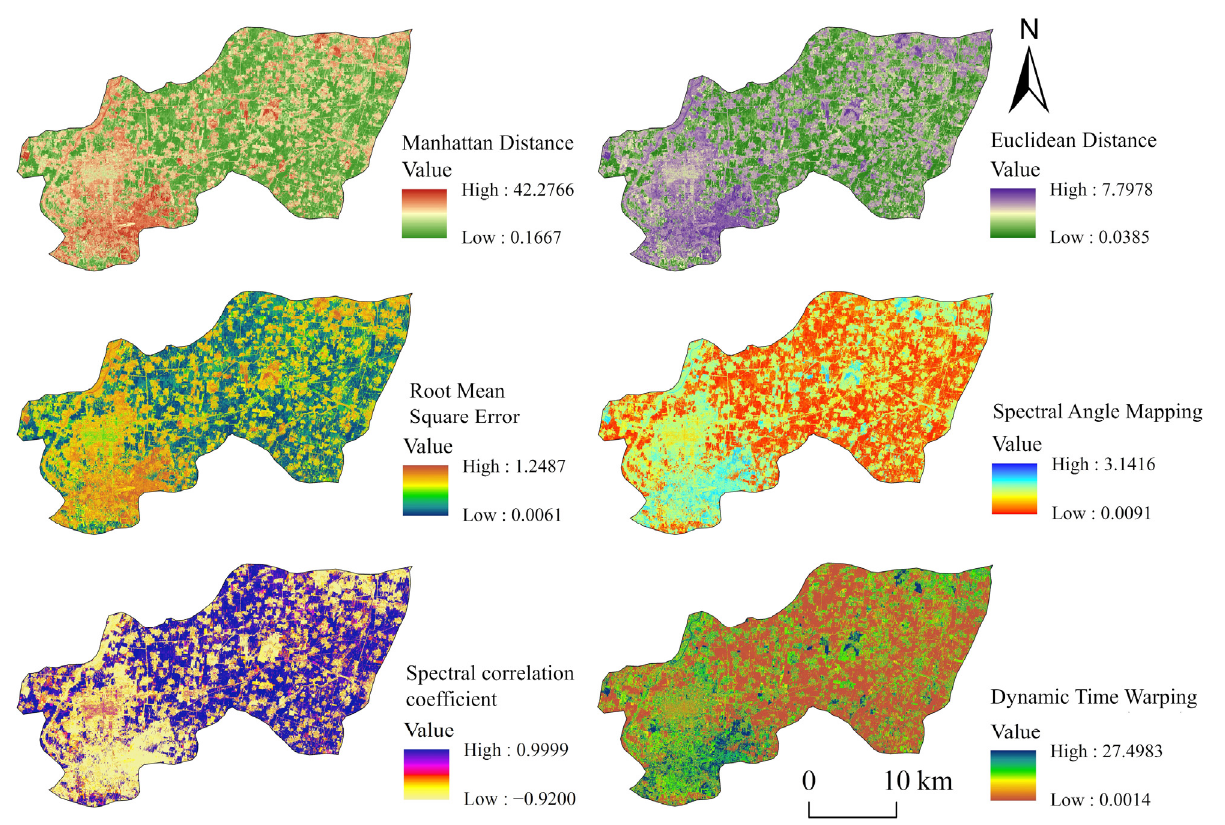
Figure 5. Calculation results of different similarity indicators.